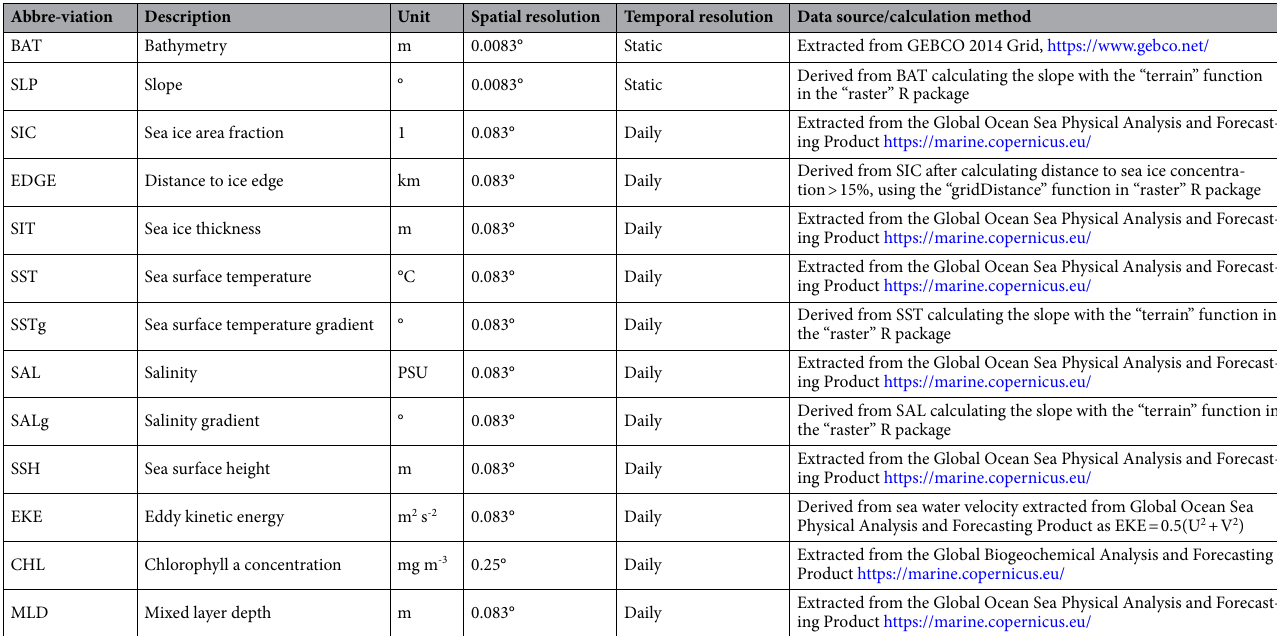
Table 2. Environmental variables used as predictors in the habitat suitability